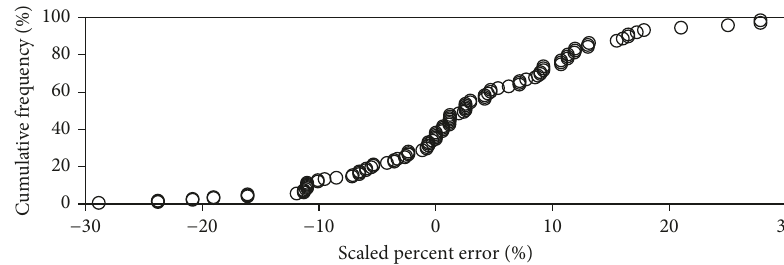
Figure 9: Scaled percent error of the BPN predicted from the MR